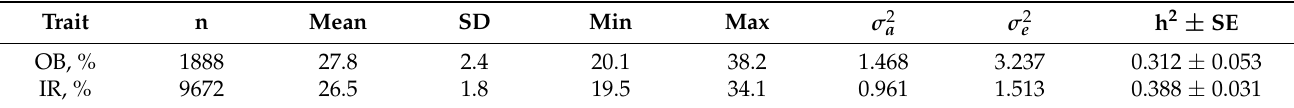
Table 2. Descriptive statistics, additive genetic variance ( σ 2 a ), residual variance ( σ 2 e ), and heritability (h 2 ) for observed ham weight loss (OB) and its infrared spectroscopy prediction (IR).